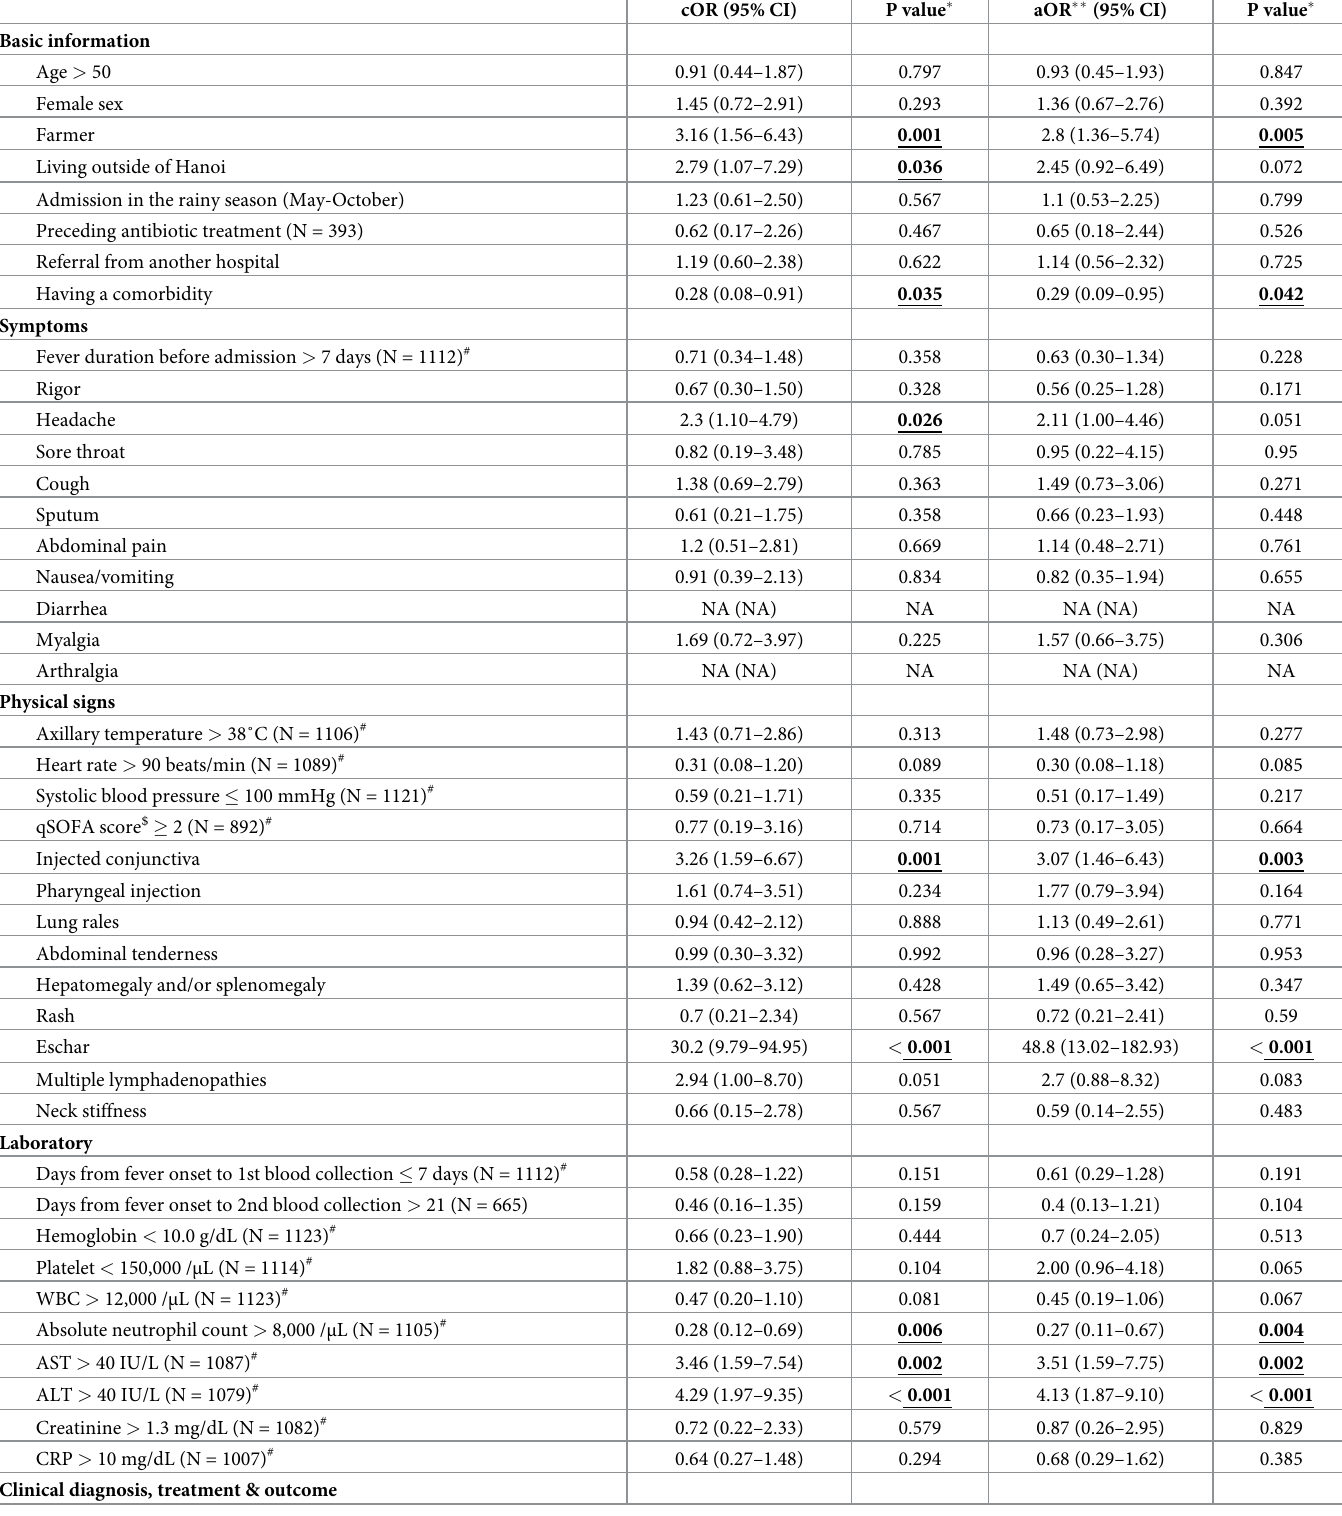
Table 2. Crude and adjusted odds ratios of being diagnosed as ST by demographic and clinical